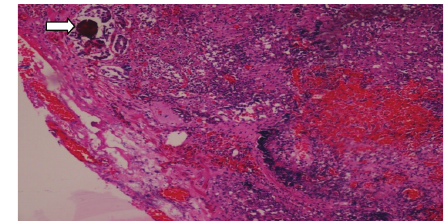
Figure 4: Hilar lymph node showing neoplastic infiltrate along with psammoma bodies